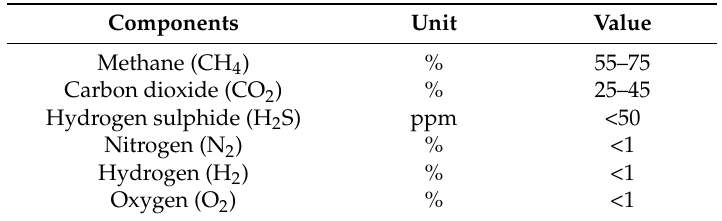
Table 4. Biogas composition in sewage sludge and food waste treatment